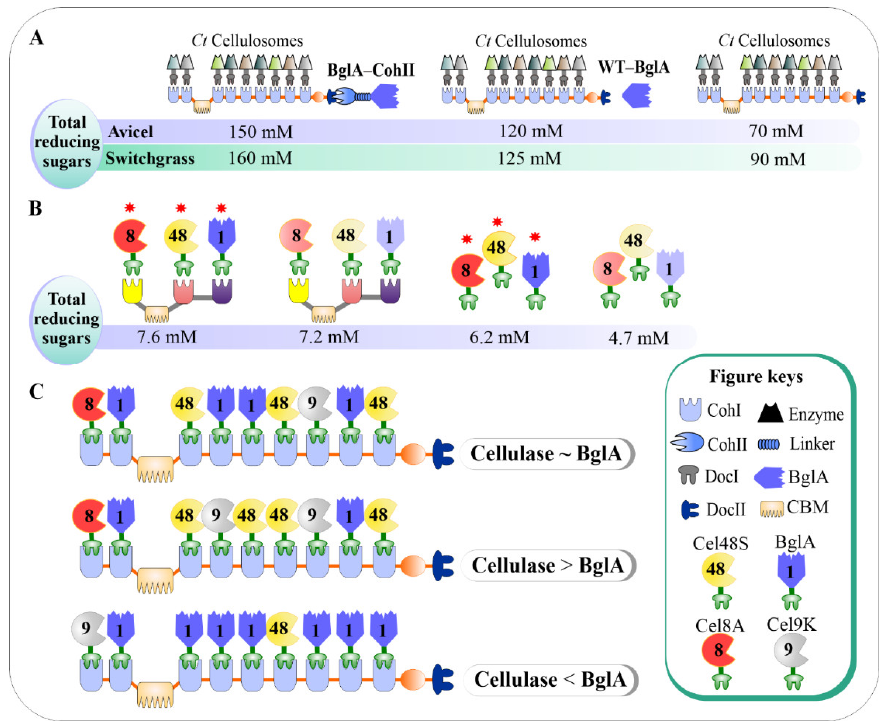
Figure 4. The incorporation of BGL into DCs aids to improve saccharification of cellulose. ( A ) The native non-cellulosomal BglA from C. thermocellum was transformed into the cellulosomal mode and integrated into Ct cellulosome via CohII–DocII interaction. ( B ) The thermostable mutants Cel8A, Cel48S, and BglA were used as cellulosomal enzyme components to construct trivalent artificial cellulosome. ( C ) The impact of ratio of BglA-to-cellulases on hydrolytic activity. Note: The asterisk (*) indicates the thermostable mutant strain.